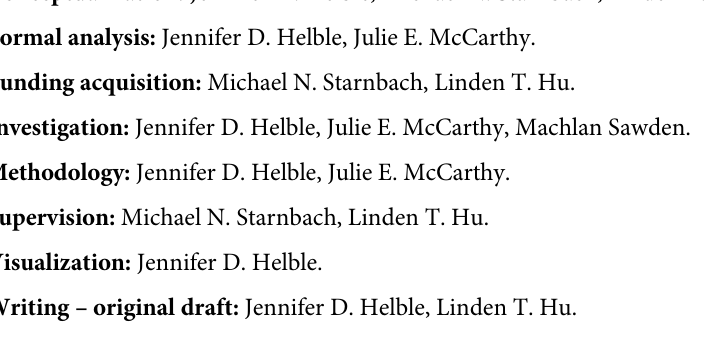
S7 Fig. PD-1 does not influence the T cell and B cell responses in the inguinal lymph nodes. WT and PD-1 -/- mice were inoculated with B . burgdorferi or media alone and inguinal lymph nodes were isolated at two, four, or eight weeks post-infection. (A) CD4 + T cells, (B) CD8 + T cells, (C) B cells, and (D) germinal center B cells were determined by flow cytometry. Data are pooled from at least two independent experiments with five mice per group and were analyzed using two-way ANOVA with Sidak’s multiple comparisons test. S8 Fig. Histopathology scoring system used to assess ankle